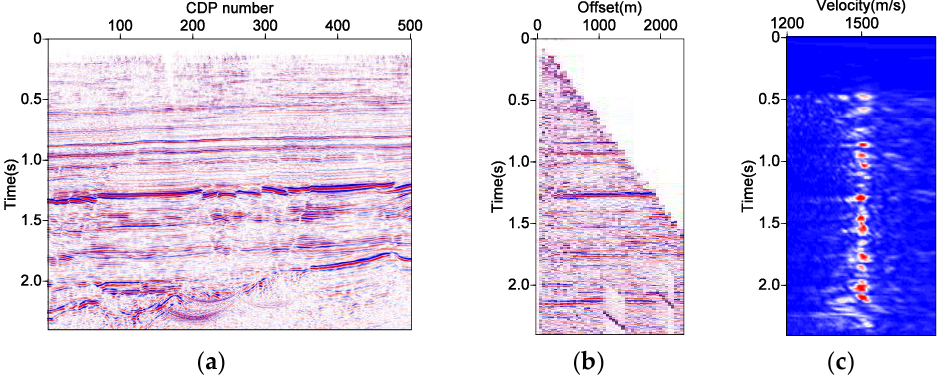
Figure 12. ( a ) Stack section; ( b ) CRP gather at CDP 203; ( c ) velocity spectrum at CDP 203.